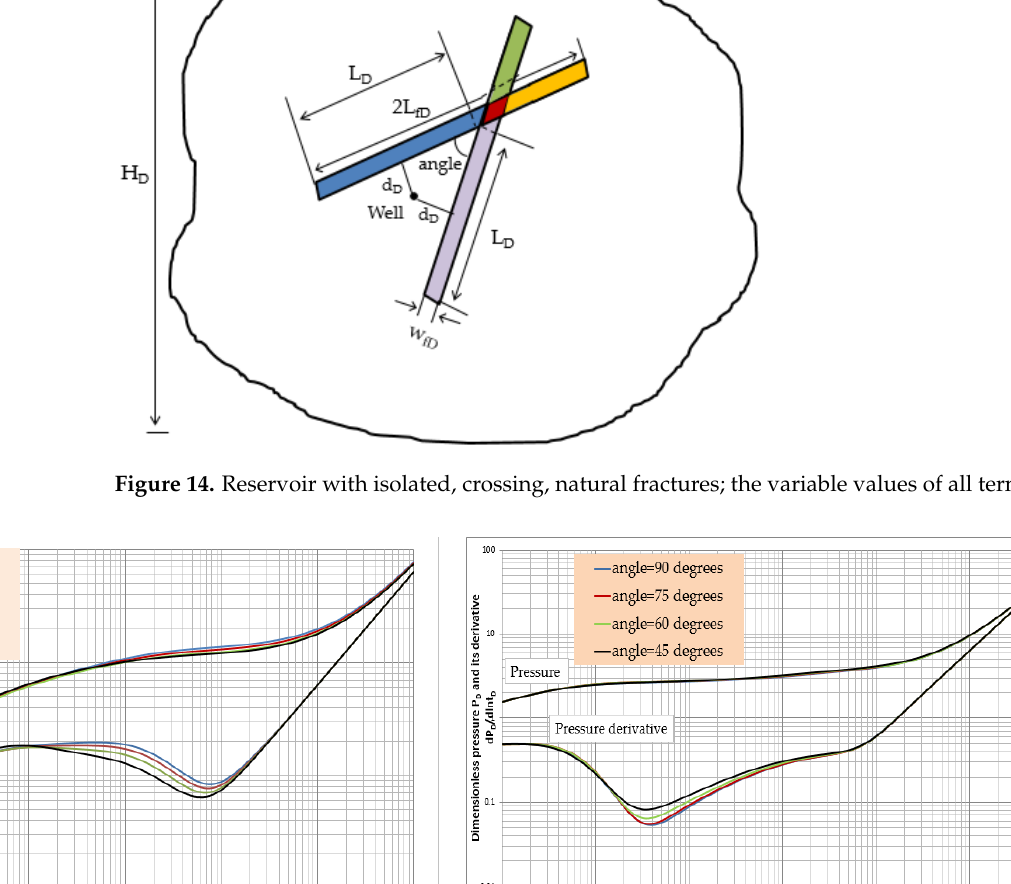
Figure 14. Reservoir with isolated, crossing, natural fractures; the variable values of all terms.